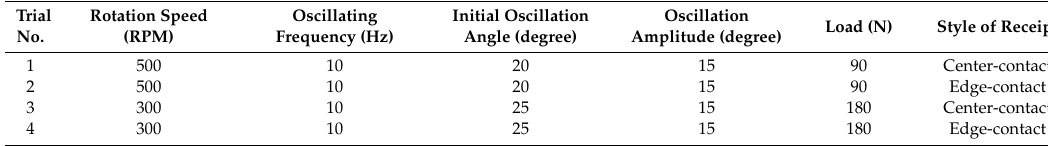
Table 2. Process parameters of test A and